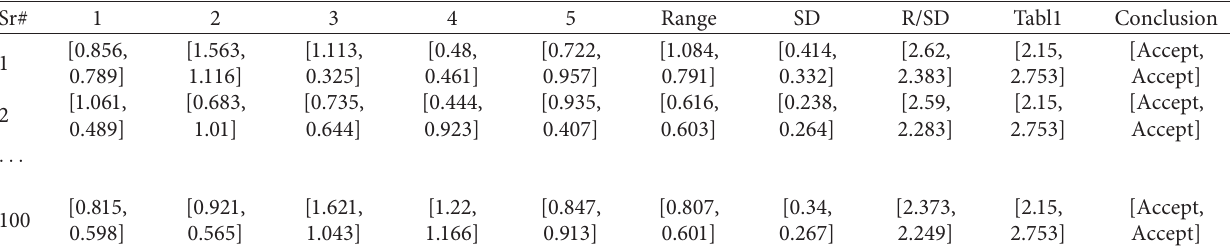
Table 2: The calculation of the proposed test statistics.